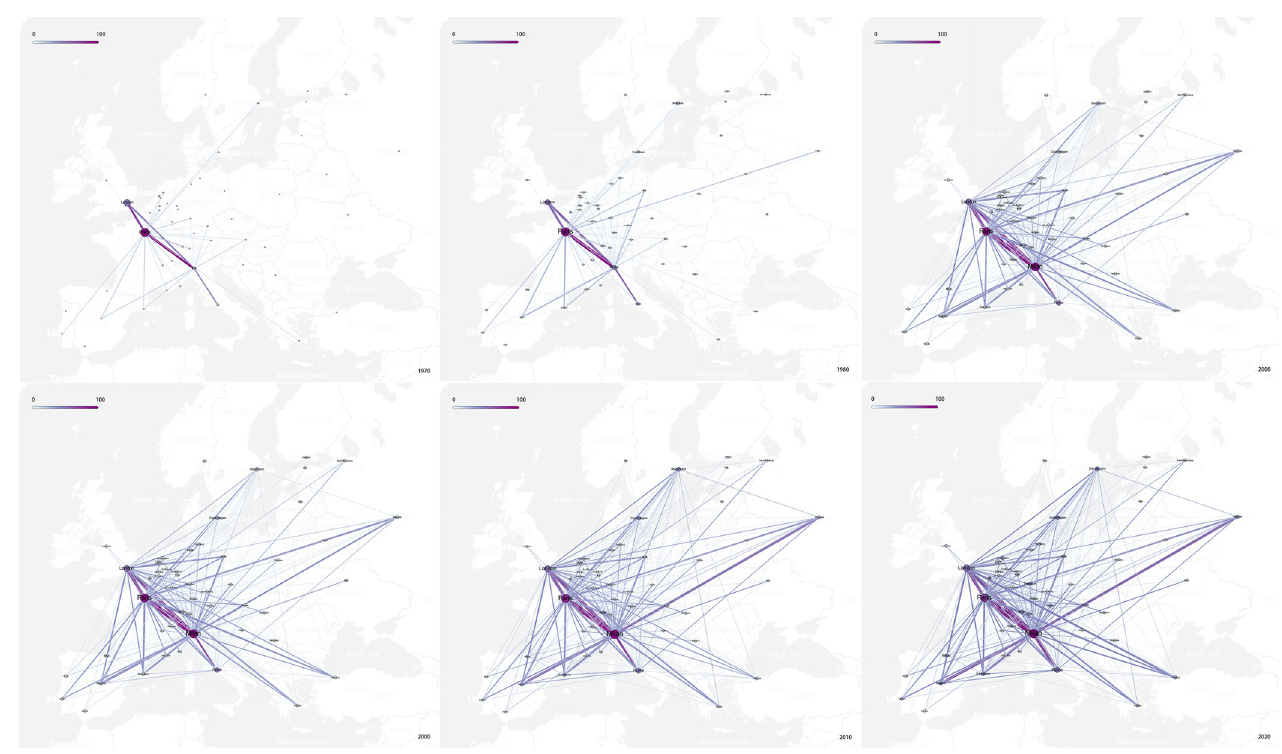
Fig 6. Creative industry interlocking network based on Milan. (Base map source: USGS National Map Viewer (public domain)).